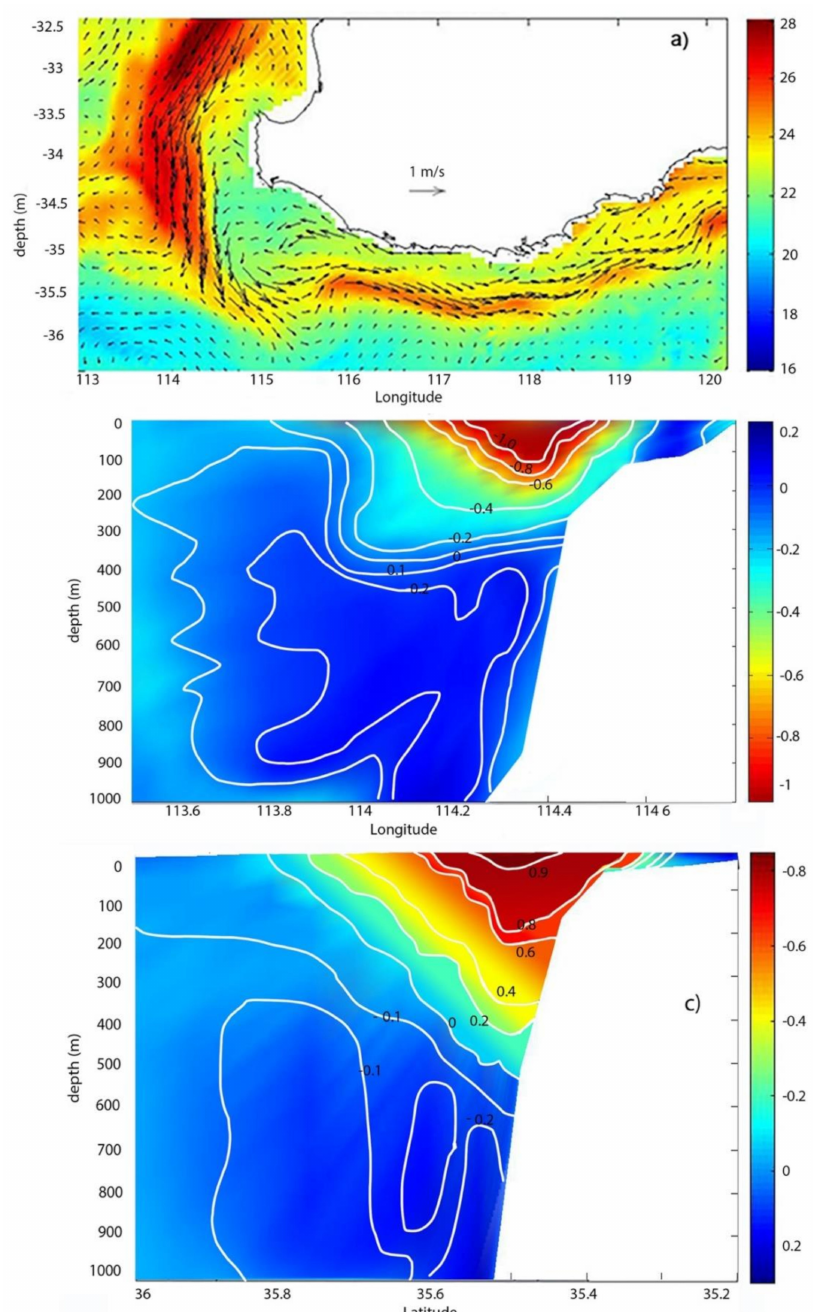
Figure 4. Model output with wind stress forcing representing summer conditions. ( a ) Sea surface temperature ( ◦ C) and current velocities; ( b ) the cross-section across transect R (Capes region) showing the north-south velocity (m / s); ( c ) the cross-section across transect K (Albany) showing the east-west velocity (ms − 1